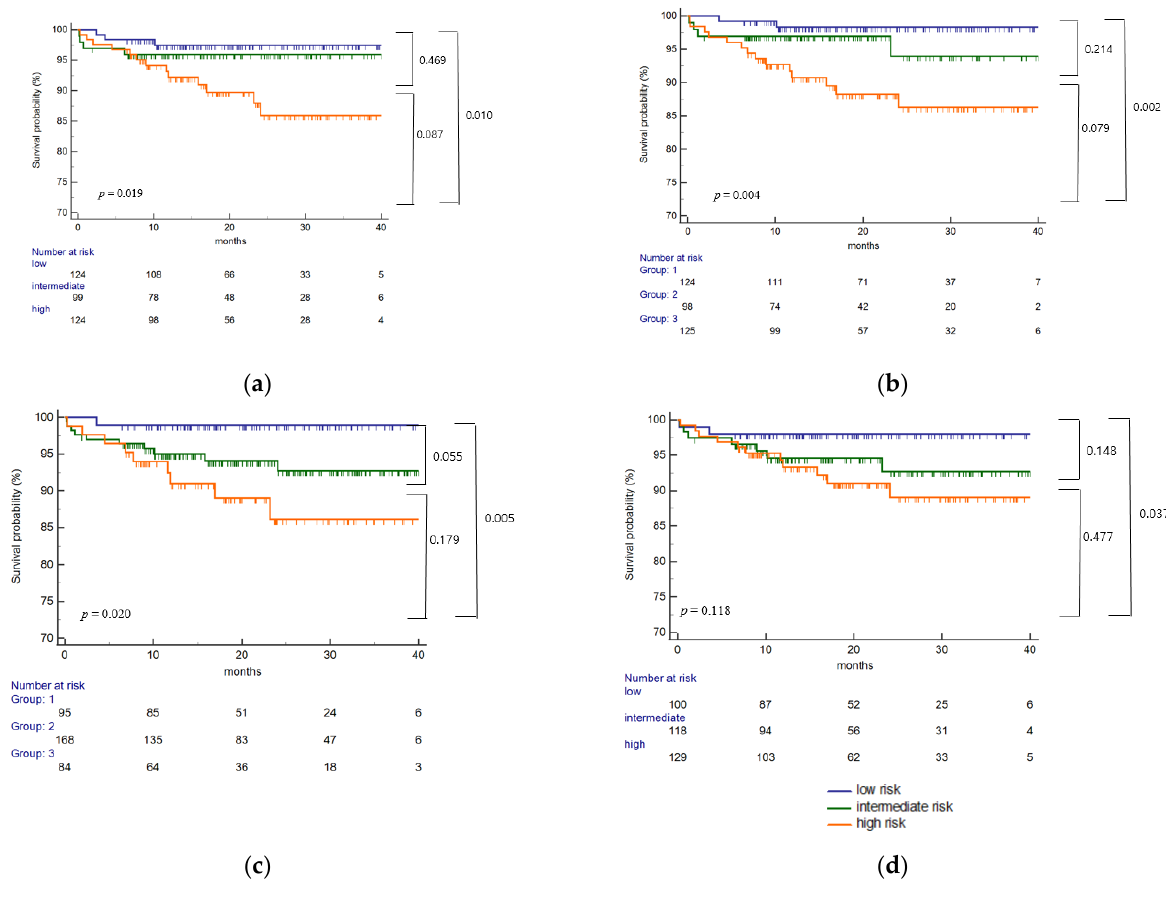
Figure 6. Eplet mismatch on the risk of antibody-mediated rejection development. ABMR-free survival was significantly associated with single molecular mismatch ( a ), total eplet mismatch ( b